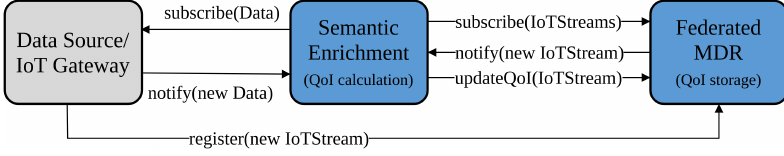
Figure 7. Semantic Enrichment (SE)–MDR